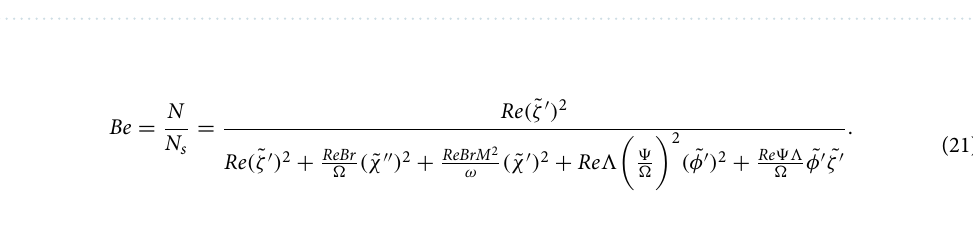
Table 3. Comparsion of present results with Sharma and Gandhi 62 for ˜ χ ′′ ( 0 ) , −˜ ζ ′ ( 0 ) , − ˜ φ ′ ( 0 )